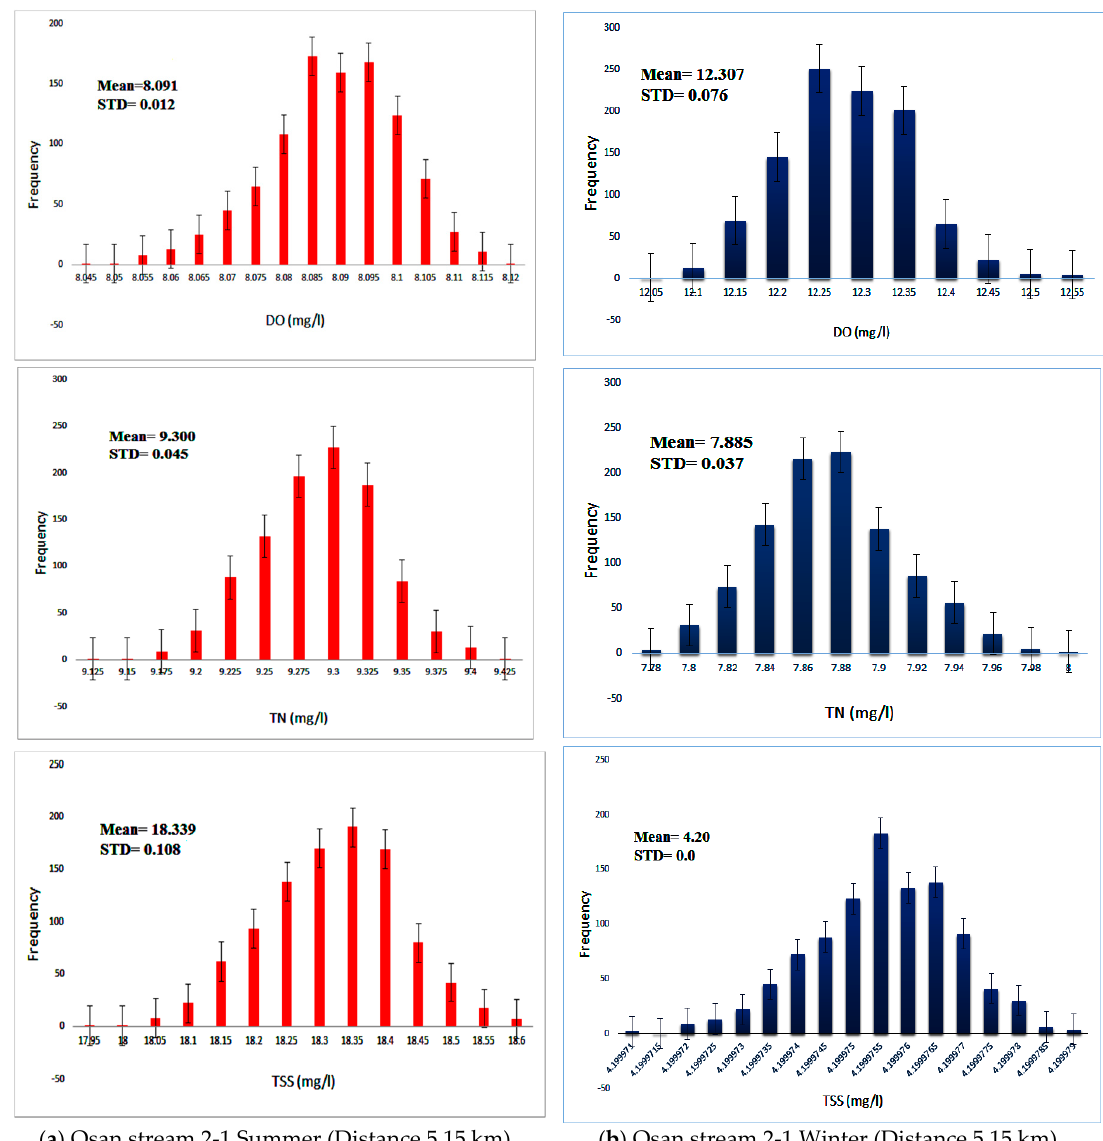
Figure 5. Error bars and frequency distribution from uncertainty analysis for BOD, DO, TN and TSS for summer and winter at Osan stream 2 ‐ 1.